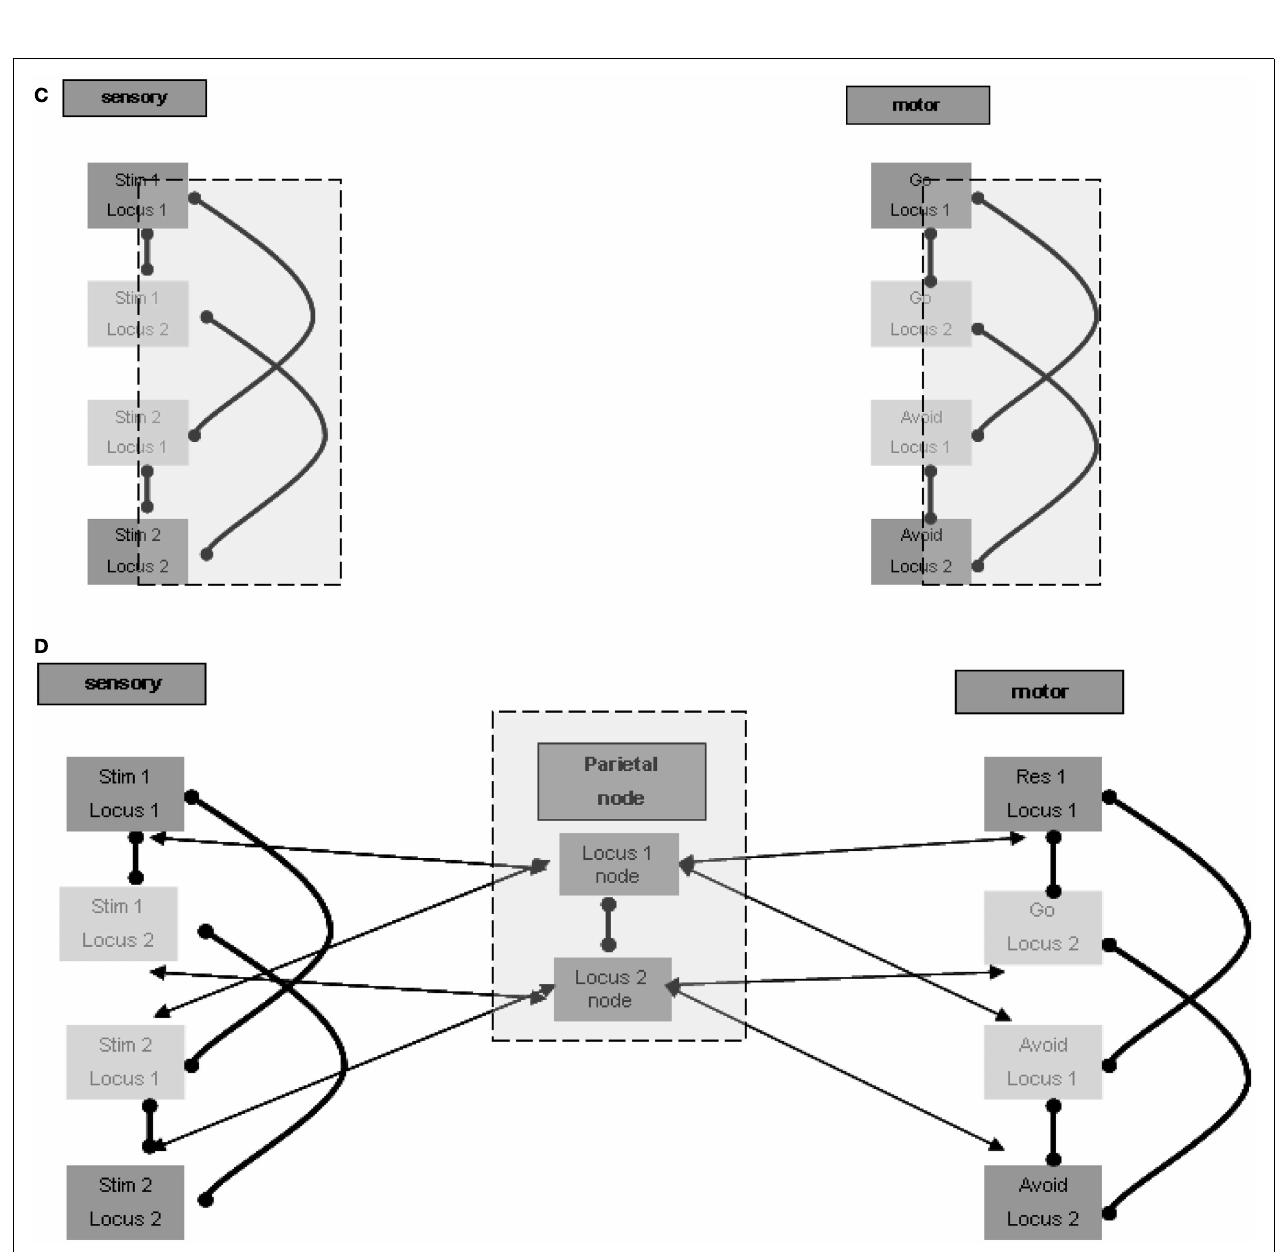
expanding model, the additive model blocks and connections are emphasized with a gray square). (C) Lateral inhibition for selection of one representation in one locus. (D) Inter-modality connection according to